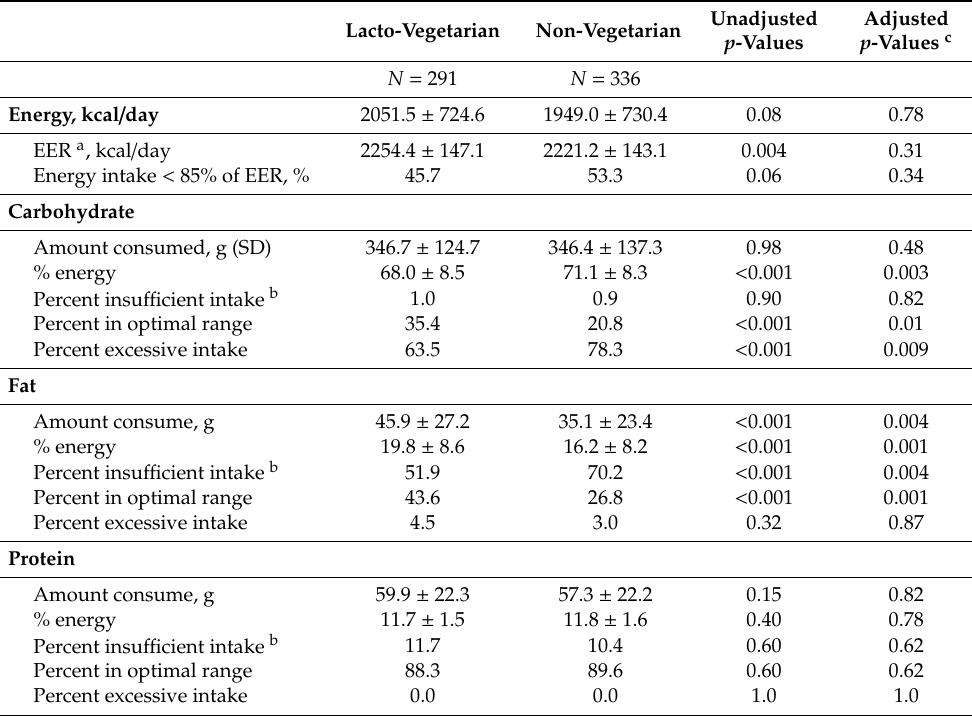
Table 2. Energy and macronutrient consumption among lacto-vegetarian and non-vegetarian pregnant women in Uttar Pradesh, India 1